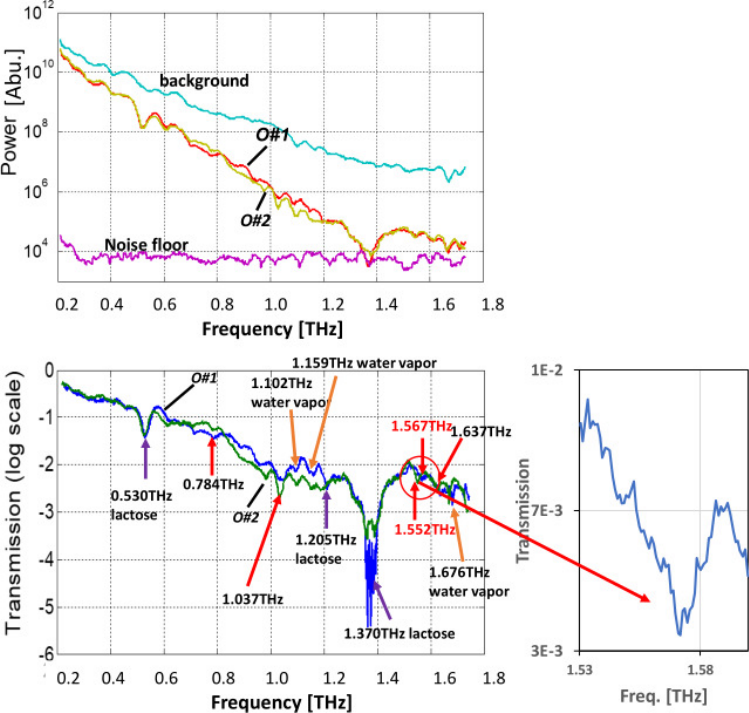
Figure 7. Spectra for oxycodone O#1 and O#2. ( Top ) Power (arbitrary unit) vs. frequency (THz); ( Bottom ) transmission vs. frequency, which is corrected with an offset frequency.